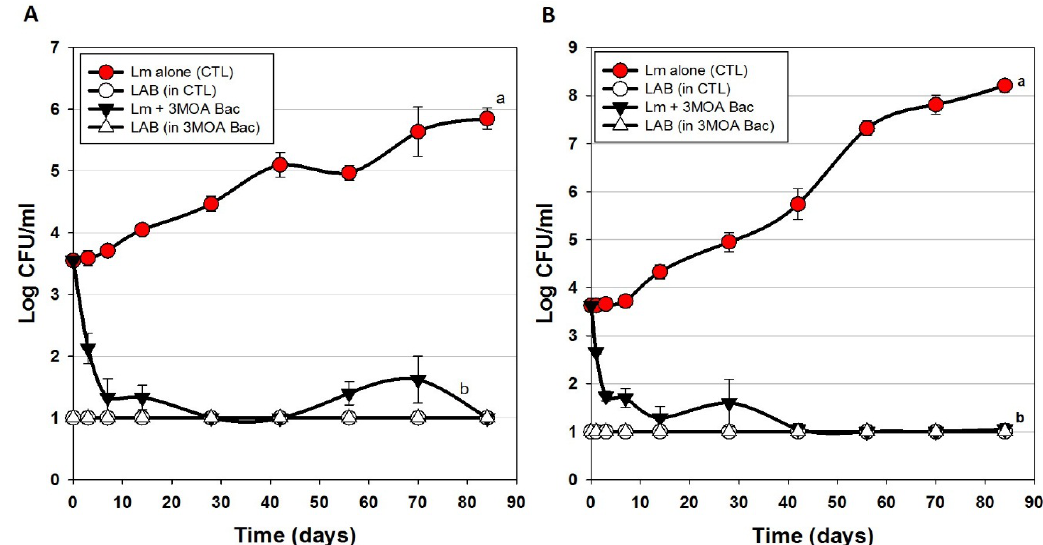
Figure 4. Hotdog challenge study with surface-applied bacteriocin extracts comprising 3 mixed MOAs. L. monocytogenes 39-2 was either inoculated onto hotdogs alone (as control) or with added bacteriocin extracts (Trial #3). ( A ) bacteriocin extracts included curvaticin FS47, pediocin Bac3, enterocin FS56-1, and enterocin FS92. ( B ) bacteriocin extracts included curvaticin FS47, pediocin Bac3, enterocin FS56-1, and lacticin FLS1. Plate counts for LAB from these treatments were made on acidified MRS (hollow symbols). All sample treatments were performed in triplicate replication; data points represent the means and error bars represent the standard deviation from the means. Treatments with different letters are significantly different (repeated measures, p < 0.05).